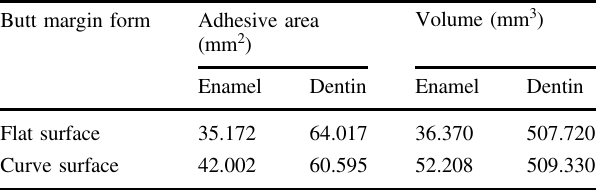
Fig. 2 The von Mises stress (MPa) distribution in teeth tissue in fl at surface ( a, c ) and curve surface ( b, d ) butt margin models under vertical load ( a, b ) and horizontal load ( c, d ). The color scale with red to blue colors corresponds to high to low-stress areas